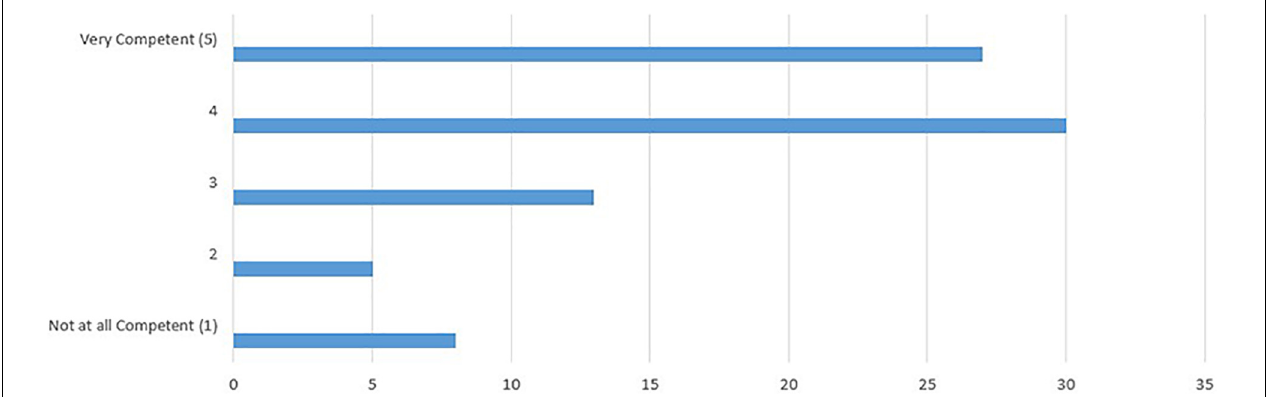
FIGURE 1 | Perceived faculty competence in using the Moodle based learning management system.